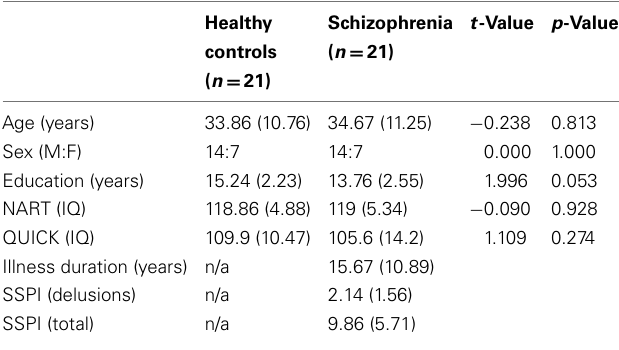
Table 1 | Sociodemographic and psychopathological group characteristics.